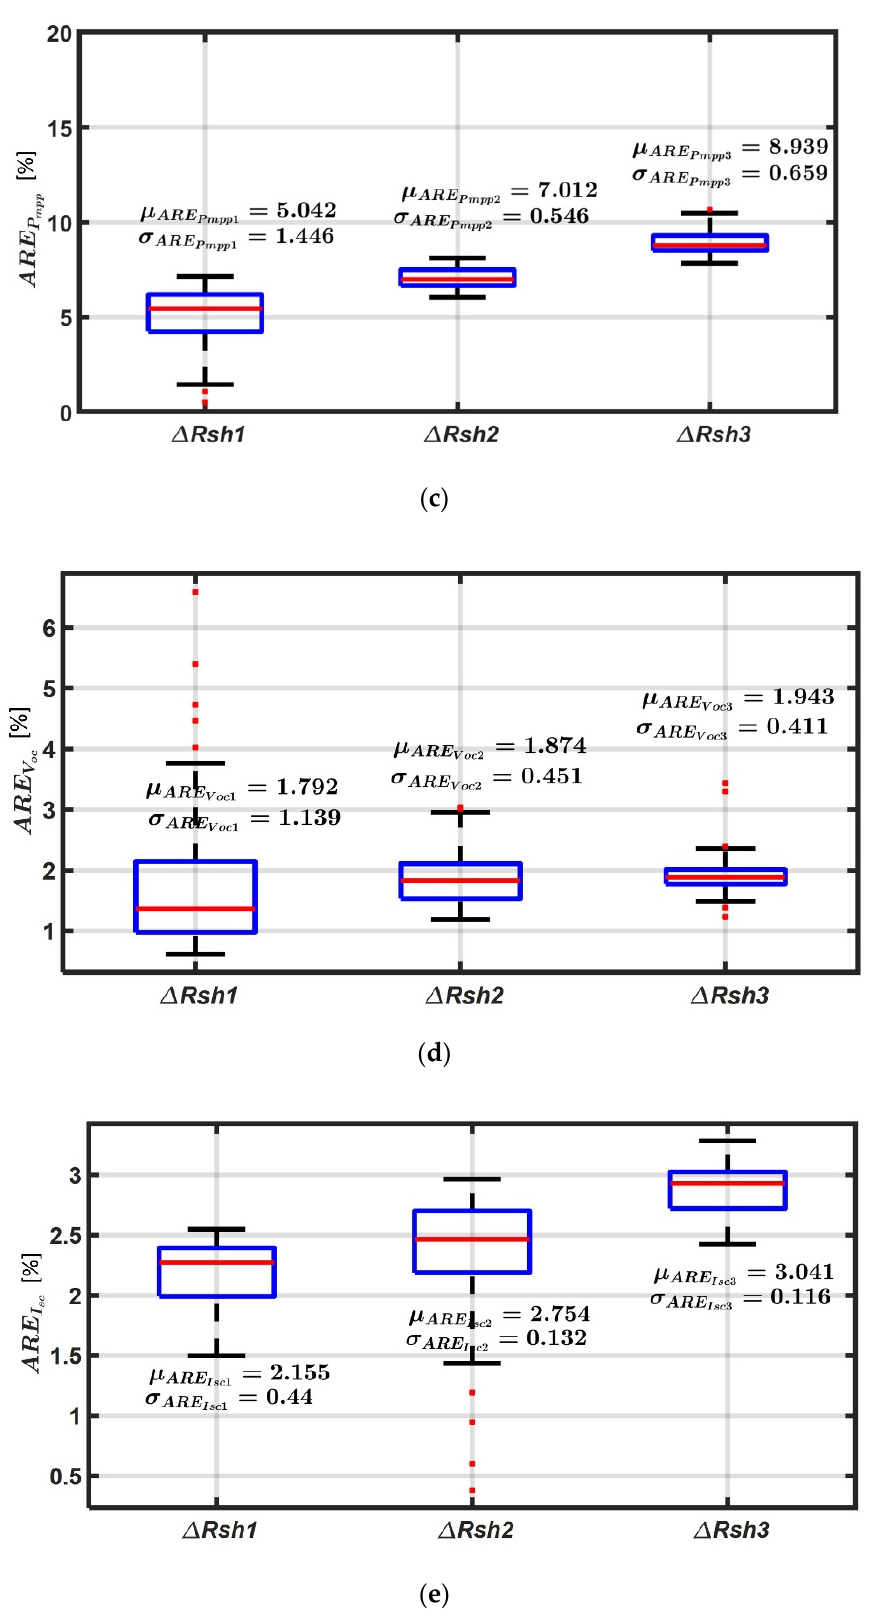
Figure 29. Effect of shunt resistance fault R sh on the I–V curve characteristics. ( a ): Fault effect on PV module’s current; ( b ): Fault effect on PV module’s voltage; ( c ): Fault effect on maximum power; ( d ): Fault effect on open-circuit voltage; ( e ): Fault effect on short-circuit current.